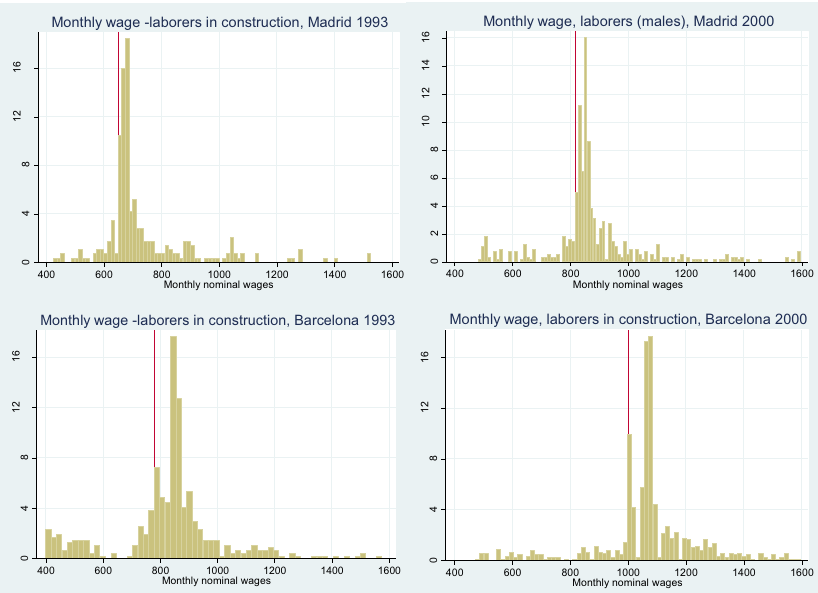
Fig. 6 Histogram of wages from social security records in selected provinces: a Madrid and Barcelona, b Alicante and Valencia. Histograms of wages of laborers (the group with lowest qualification) between 18 and 30 years of age. The distribution covers the range 400–1600 euro. The vertical line depicted represents the bargained wage for laborers in the collective agreement in construction. a The width of the bins is 19.6 euro in Barcelona and 12 euro in Madrid (1993), chosen so as the collective agreement wage coincides with the starting point of its bin. b The width of the bins is 12 euro in Alicante and 10 euro in Valencia (1993), chosen so as the collective agreement wage coincides with the starting point of its bin